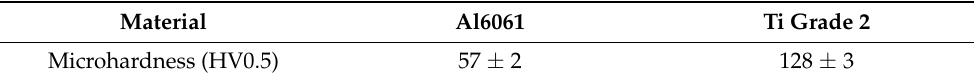
Figure 3. Low magnification SEM-BSE micrograph of the cross-section of Ti Grade 2/Al6061 sample, showing titanium wires embedded in the Al6061 matrix. The apparent elipticity is caused by tilting the wire with respect to the specimen surface. Table 2. Vickers microhardness of the sintered